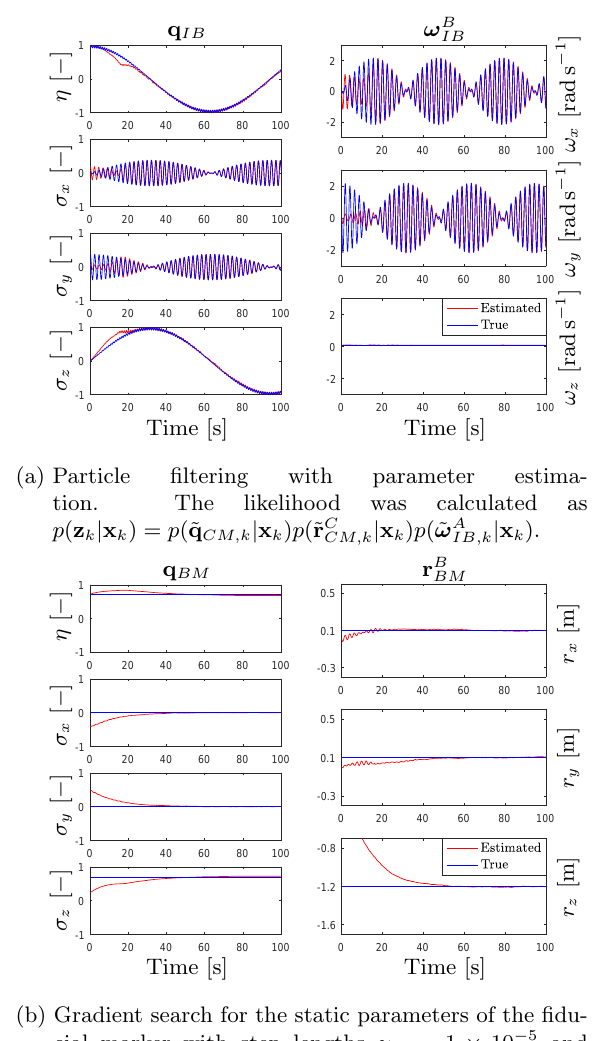
(a) Particle filtering with parameter estima- tion. The likelihood was calculated as